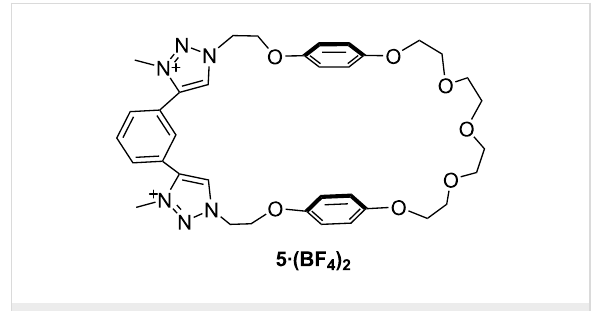
Figure 5: Chemical structure of compound 5